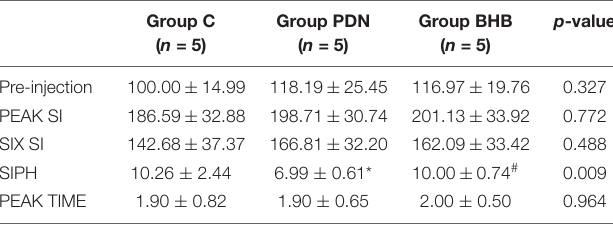
TABLE 1 | MRI signal intensity (SI) obtained from the lumbar enlargement.